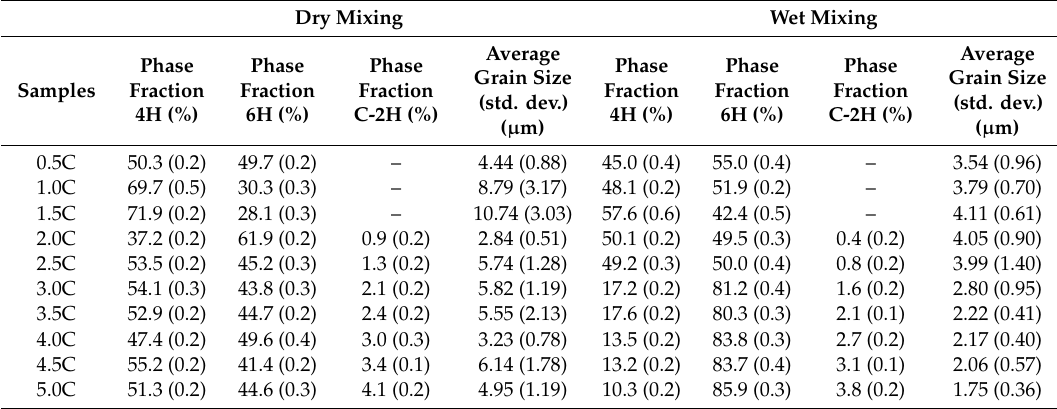
Table 3. Rietveld refinement (quantitative analysis) of dry mixed–wet mixed SiC